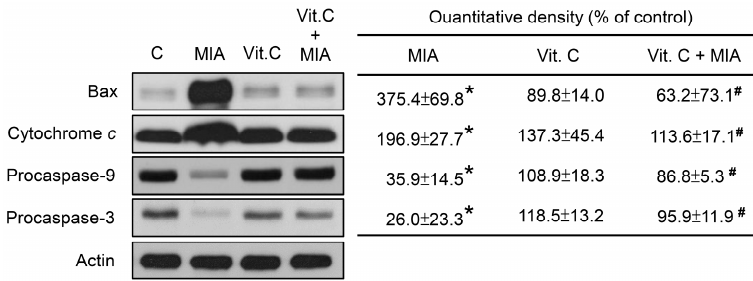
Figure 4. Effects of MIA and/or vitamin C on apoptosis-related protein expression. SW1353 cells were incubated with 100 μ M vitamin C in the presence or absence of 5 μ M MIA for 24 h, and then the cells were harvested. The proteins were extracted and Bax, cytochrome c , procaspase-9, and procasepase-3 were measured. β -actin was used as the internal control. The data of the right panel are expressed as the relative density compared to that in untreated cells (control), which was 100%. The results are the mean ± S.D. for three separate experiments. * p < 0.05 compared to the corresponding untreated control. # p < 0.05 compared to the corresponding MIA treated group.